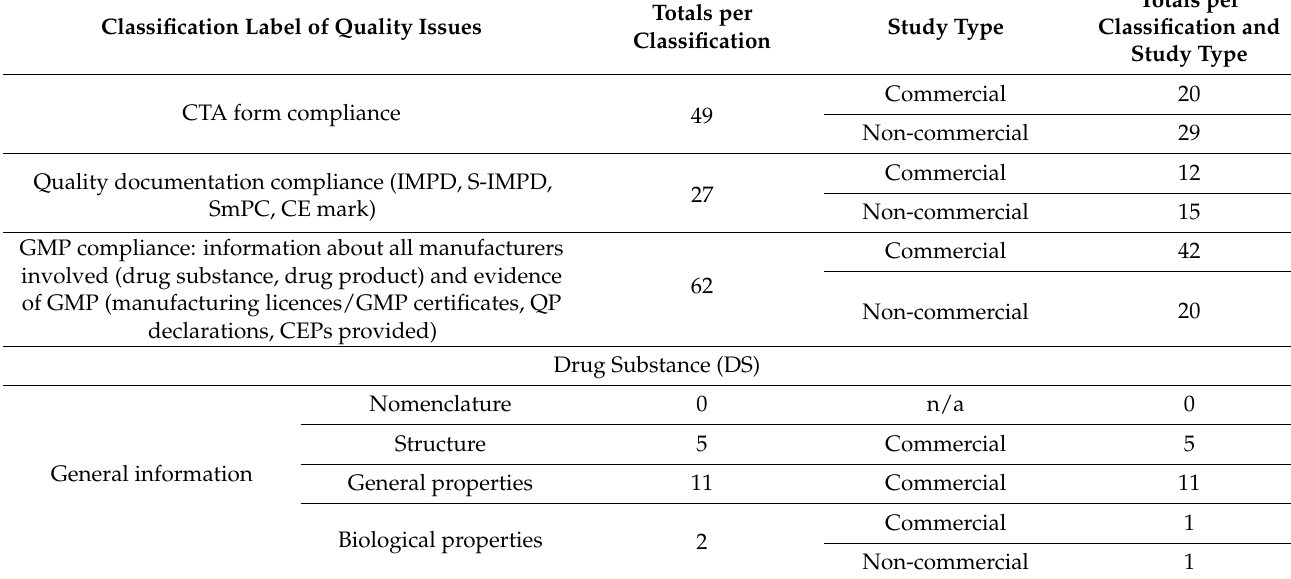
Table A1. Number of quality issues and their classification for COVID-19 CTs assessed from March 2020 to March 2021.